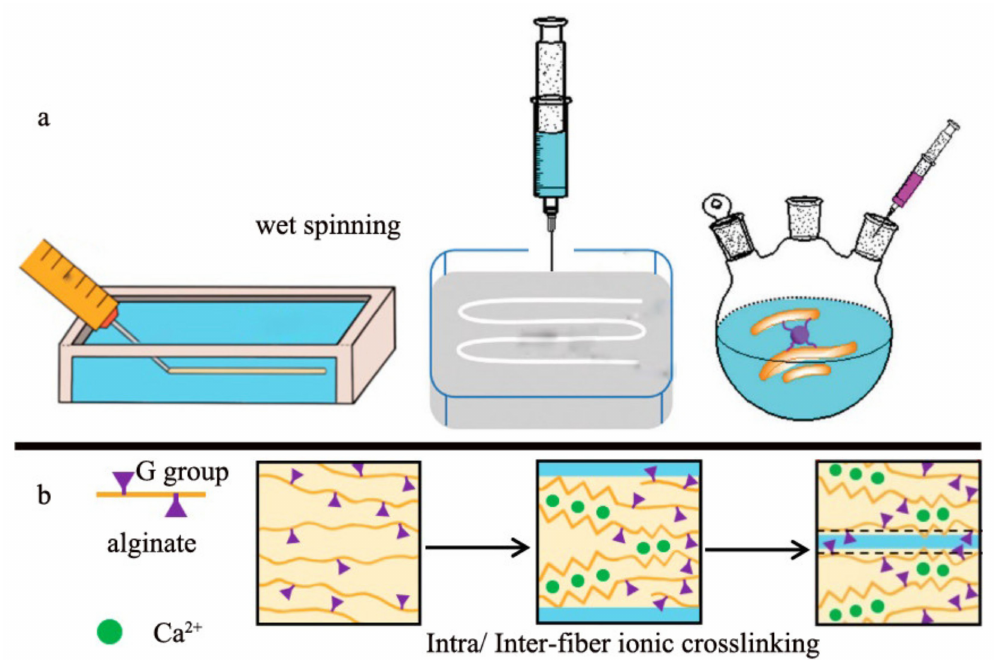
Figure 6. A mini modified version wet spinning device, ( a ) schematic diagram of the fiber spinning and ( b ) the formation mechanism of